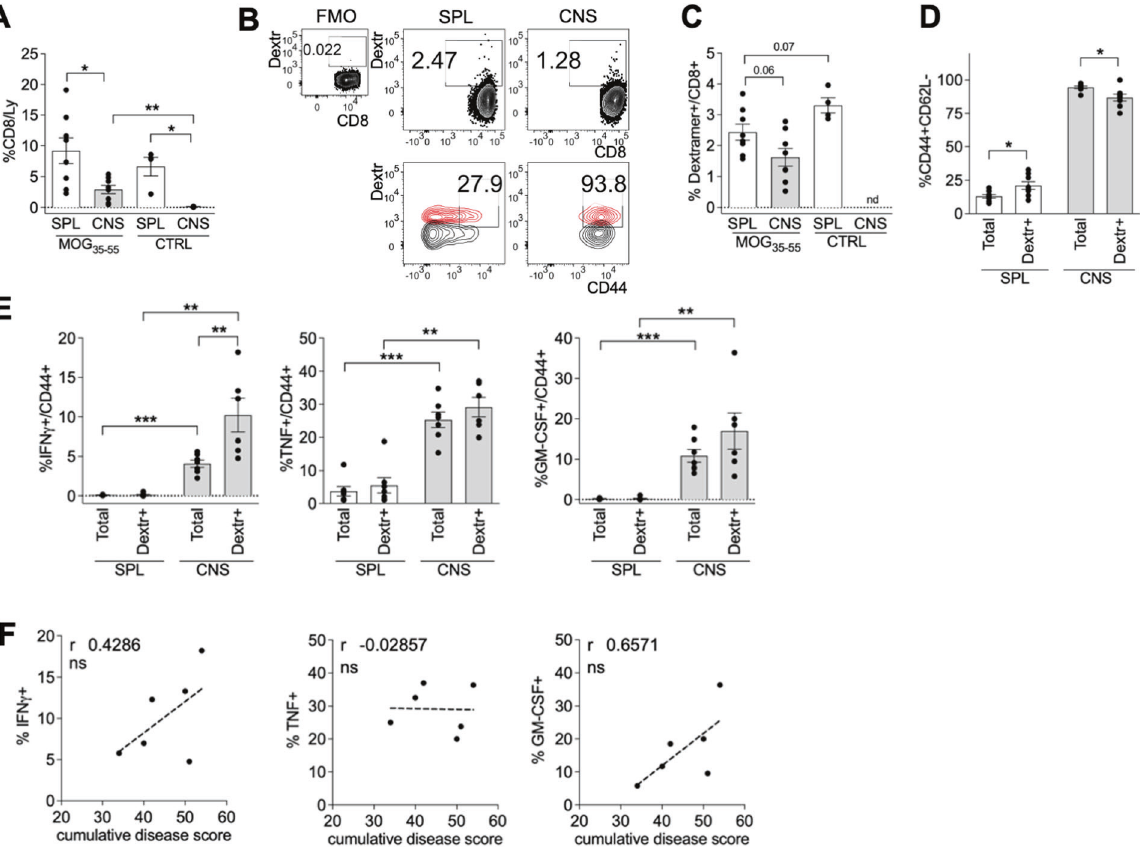
Fig. 2 AE-speci fi c CD8 + T cells display an effector/memory phenotype in the CNS of mice with EAE. C57BL/6 mice ( n = 8) were immunized with 100 µg